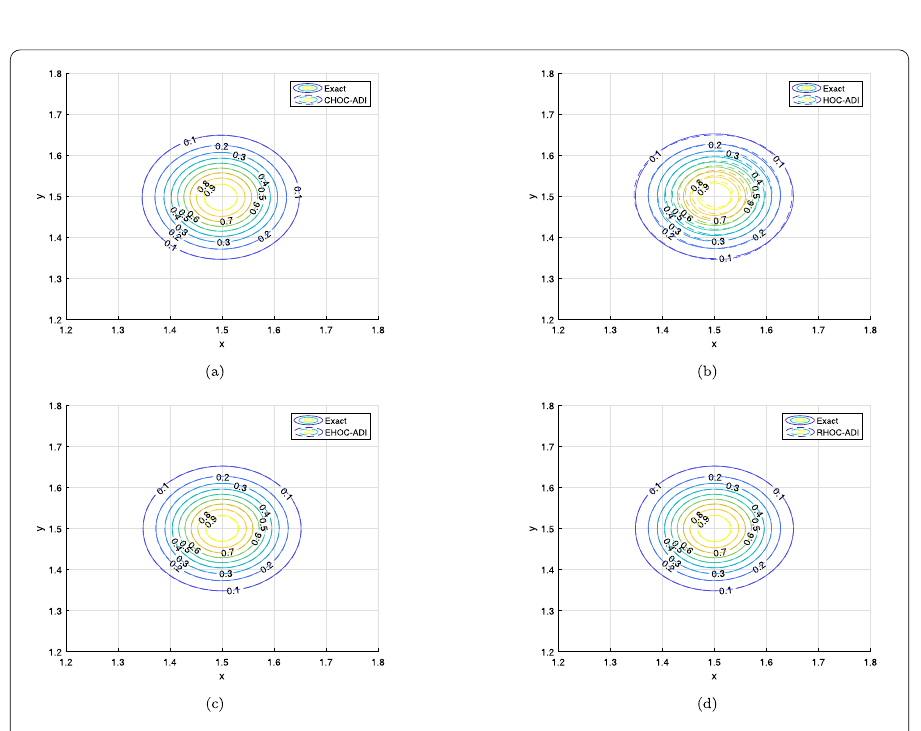
Figure 7 Contour lines of pulses in the sub-region 1.2 ≤ x , y ≤ 1.8 at final time t = 0.0001 with Pe = 10,000 and τ = 2.5 × 10 –7 : ( a ) exact and present DHOD-ADI, ( b ) exact and HOC-ADI, ( c ) exact and EHOC-ADI, and ( d ) exact and RHOC-ADI. Dash-dot contour lines in ( a )–( d ) correspond to numerical